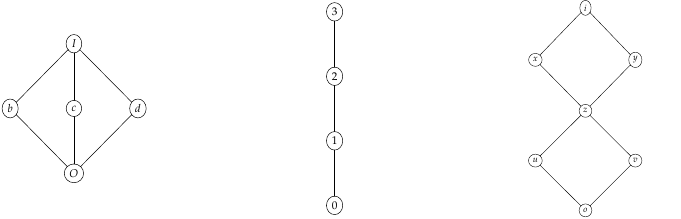
Figure 3. Complete lattice assigned to attribute a 1 ( left ), to attribute a 2 ( center ) and to attribute a 3 ( right